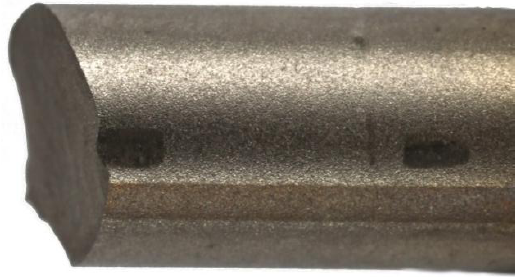
Figure 9. Magnified lateral view of Ti-CG post biomechanical testing: fatigue fracture of the rod at the rod-screw junction, illustrating surface marks of the tightened screws on the rod.